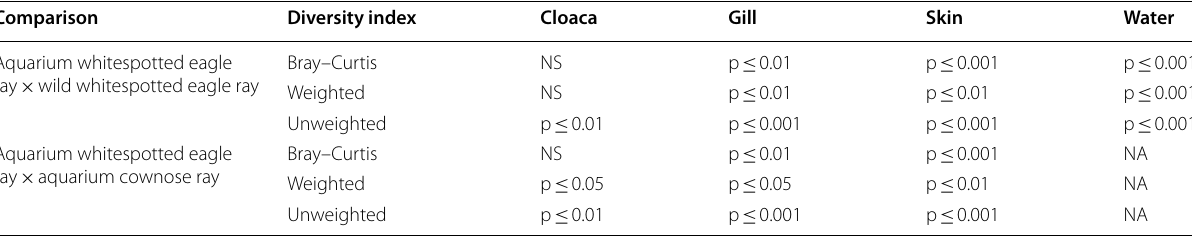
NS indicates not significant (p > 0.05). NA indicates no possible comparison. β‑diversity metrics include Bray–Curtis, weighted UniFrac, and unweighted